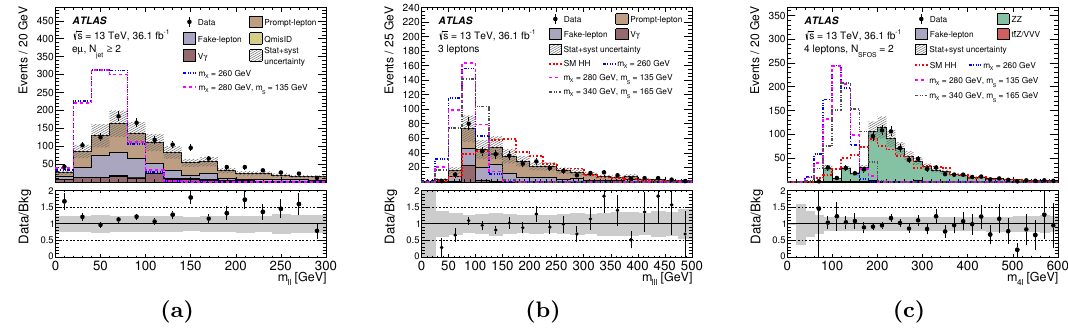
Figure 1 . Distributions of the invariant mass of (a) two, (b) three, and (c) four leptons for the two, three, and four lepton channels after preselection. The charge misidenti(cid:12)cation background in the two lepton channel and the non- ZZ backgrounds in the four lepton channel are non-zero but are too small to be seen in the distributions. The shaded band in the ratio plot shows the systematic uncertainty in the background estimate. Resonant HH signal samples are denoted by m X . The integral of each signal sample distribution is scaled to that of the expected